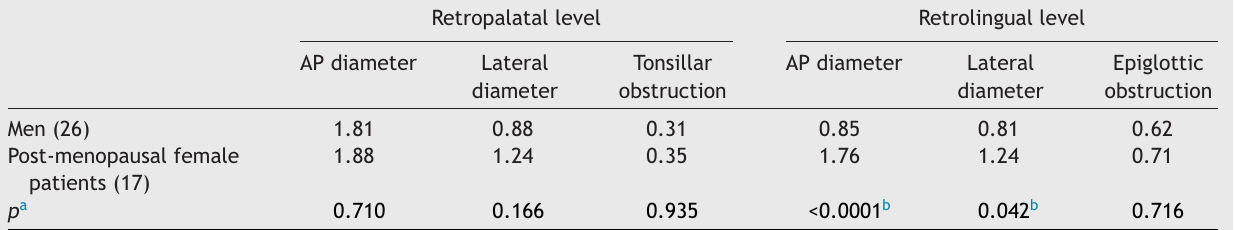
Comparison of DISE score between post-menopausal female patients (BMI < 25) and men (age ≥ 50; BMI < 25).